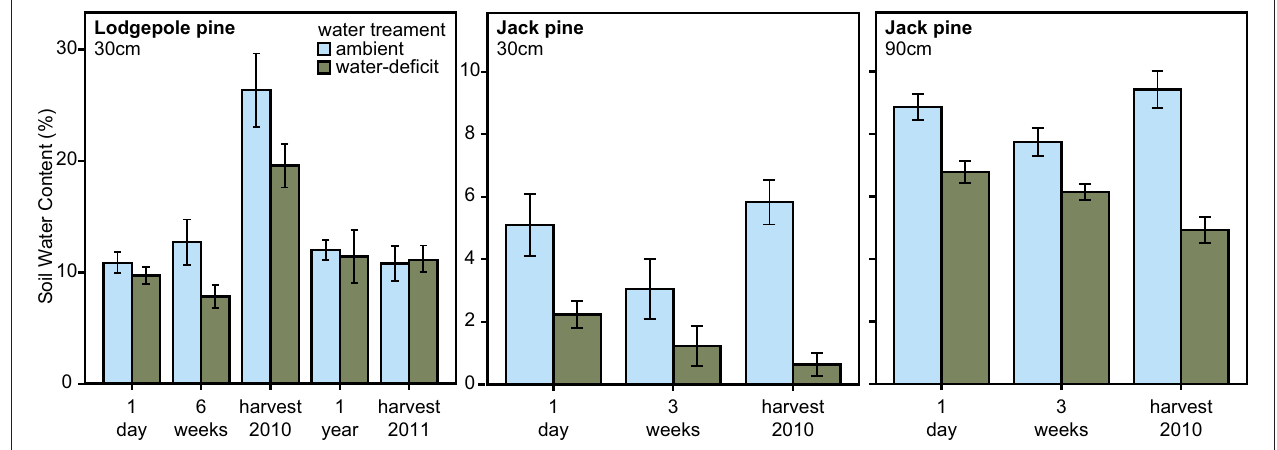
FIGURE 2 | Soil water content (mean ± S.E.) measured at 30cm soil depth for the lodgepole pine site ( P. contorta ; repeated measures ANOVA, 2010: P = 0.007 ; 2011: not significant) and at 30 and 90cm soil depth for the jack pine site ( P. banksiana ; repeated measures ANOVA, 30cm: P = 0.002 ; 90cm: P < 0.001 ) over the time course of the experiment.